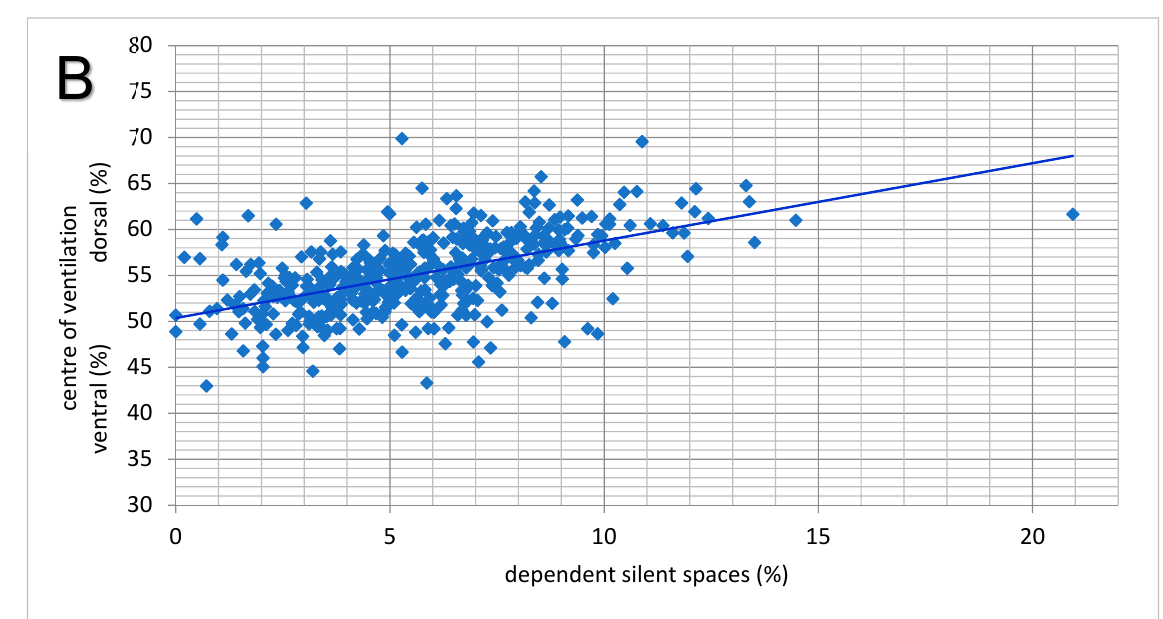
Figure 4. ( A ) Means and standard deviations of the dependent silent spaces (poorly or nonventilated ventral lung regions; solid line) and trend line (dotted) in 20 neonatal calves. The measuring times are graphed equidistantly. Values with an asterisk differ from the value at time 0. ( B ) Correlation between percentage values of the ventrodorsal centre of ventilation and the dependent silent spaces ( r = 0.55; p < 0.00001).